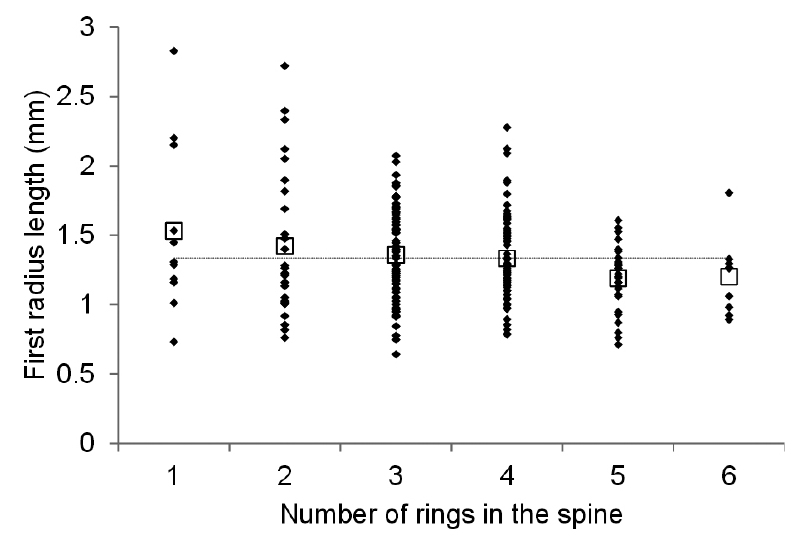
FIGURE 4 | Distances from the center of the spine to the first ring (black diamonds) in individuals of Pseudoplatystoma corruscans with different numbers of growth rings and their respective mean values (squares). The horizontal line represents the general mean